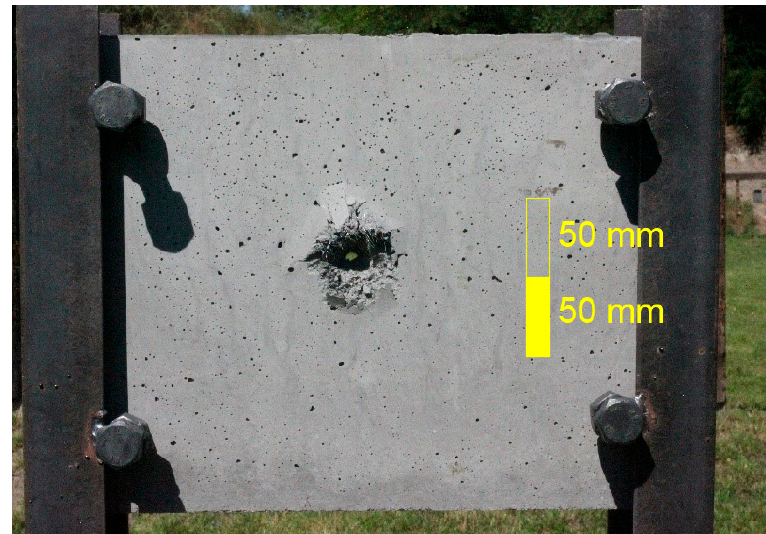
Figure 5. Sample after ballistic test.